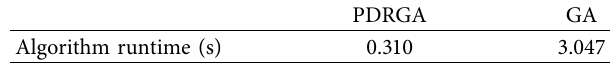
Table 4: Optimization algorithm running